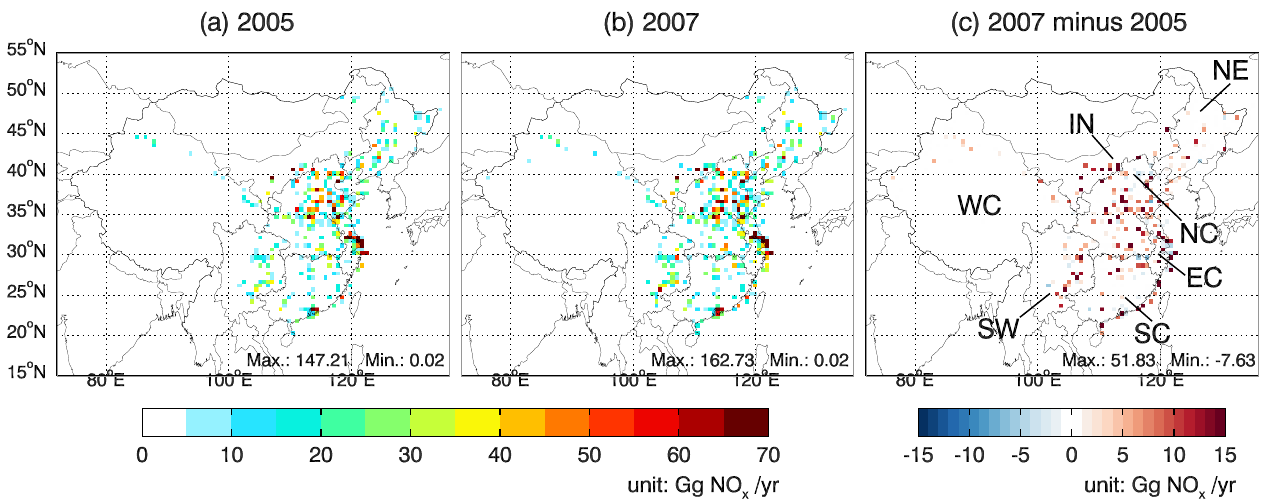
Fig. 2. Spatial distributions of annual coal-fired power plant NO x emissions for 2005 and 2007 and the changes. The maximum values and minimum values are indicated. Solid lines within the Chinese national boundaries denote the seven regions discussed in the text: NE-